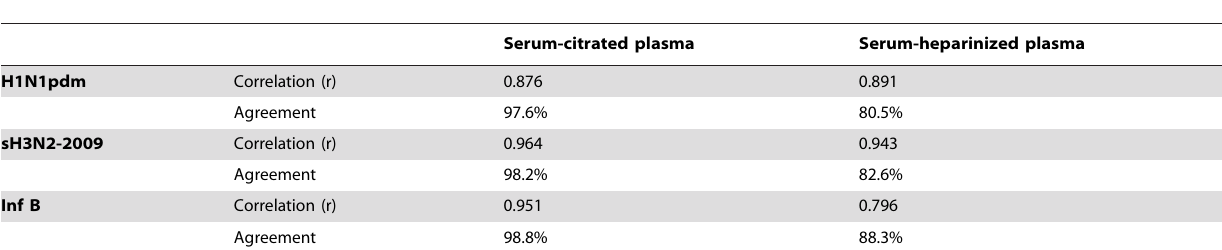
Table 3. Correlation and Agreement for two serum-anticoagulated plasma sample